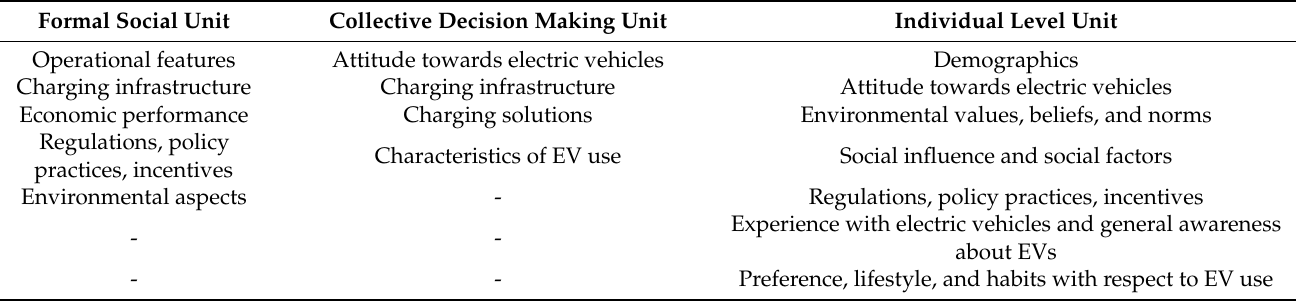
Table 1. Factors influencing EV adoption decision